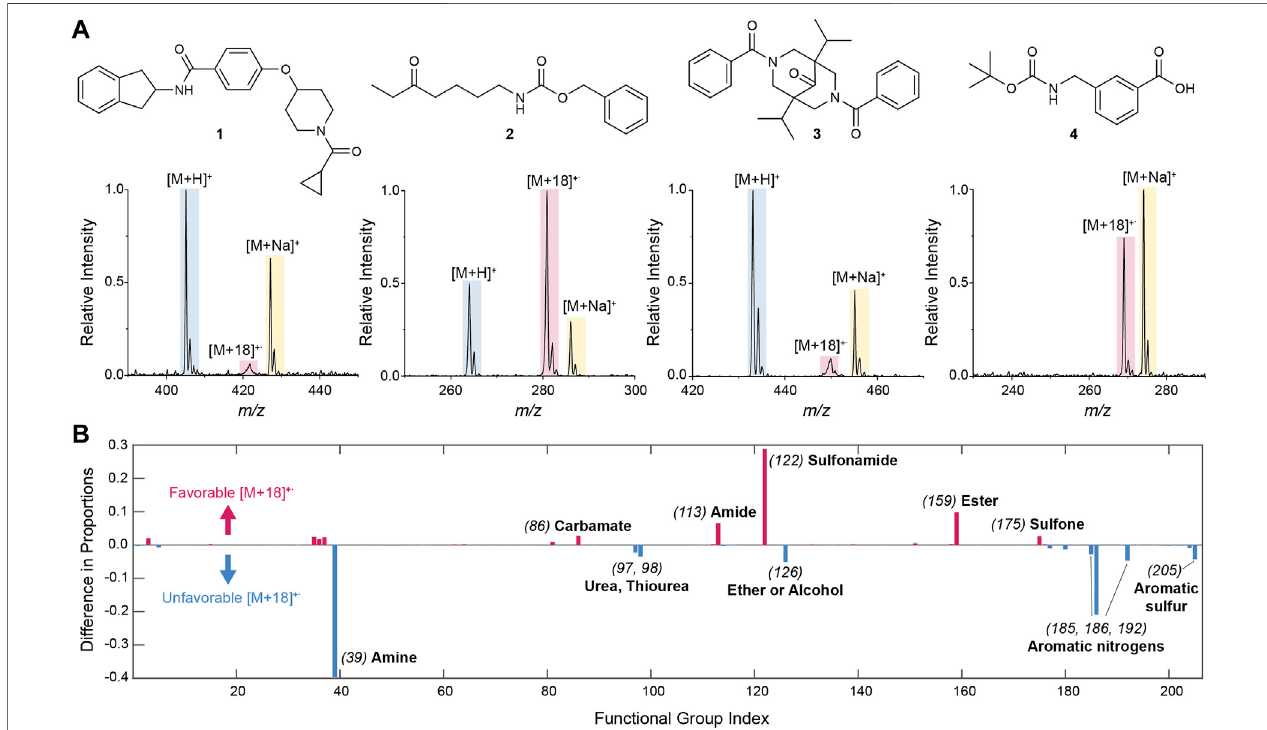
FIGURE 1 | (A) Representative examples of mass spectra from the 20,798-compound library showing cases of high and low [M+18] + _ intensity. Note the peak broadeninginthelowintensitycases.Thestructuresofthemoleculescorrespondingtotheexamplespectraarealsoshown. (B) Effectoffunctionalgroupspresentinthe molecule on the generation of [M+18] + _ as estimated from the difference in the proportion of compounds with a functional group within the set of [M+18] + _ hits and the same proportion in the complete library ( Supplementary Equation S3 ). A difference of zero indicates no effect of the functional group. Signi fi cant positive differences indicate that the formation of the [M+18] + _ species is favored by the presence of the functional group, whereas signi fi cant negative differences indicate a disfavoring effect. For the sake of simplicity, functional groups are indicated by indices speci fi ed in Supplementary Table S1 .